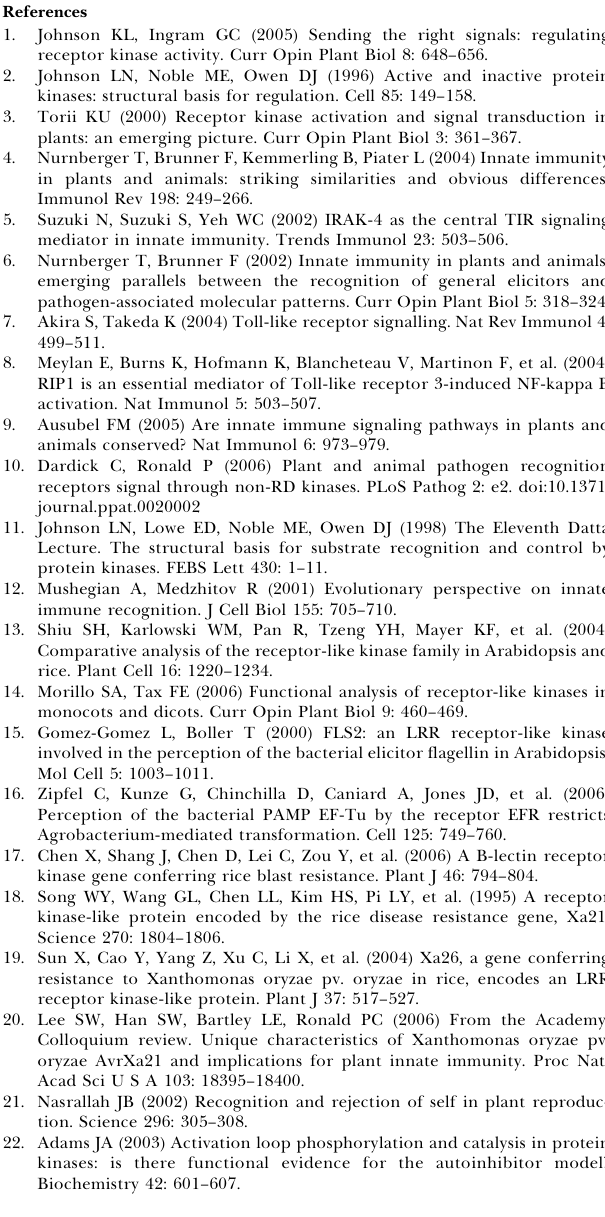
Figure S5. XB15-smGFP2 Is Functional Protein Possessing PP2C Catalytic Activity XB15-smGFP2 fusion protein and smGFP2 alone were purified from protoplasts transformed with each construct. Approximately 1 l g of each protein was incubated with 200 l M substrate in PP2C buffer for 60 min. For the boiled XB15-smGFP2, one l g of XB15-smGFP2 was boiled in water for 20 min. The data are average value of three experiments. Error bars represent standard deviations. Found at doi:10.1371/journal.pbio.0060231.sg005 (410 KB